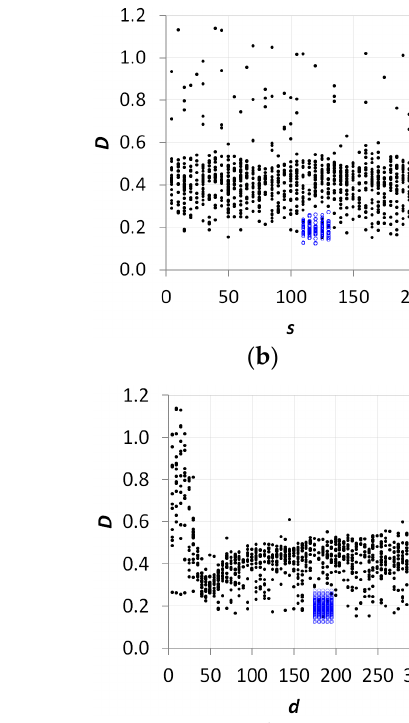
Table 2. Segmentation parameters and images acquired in arid and temperate periods.